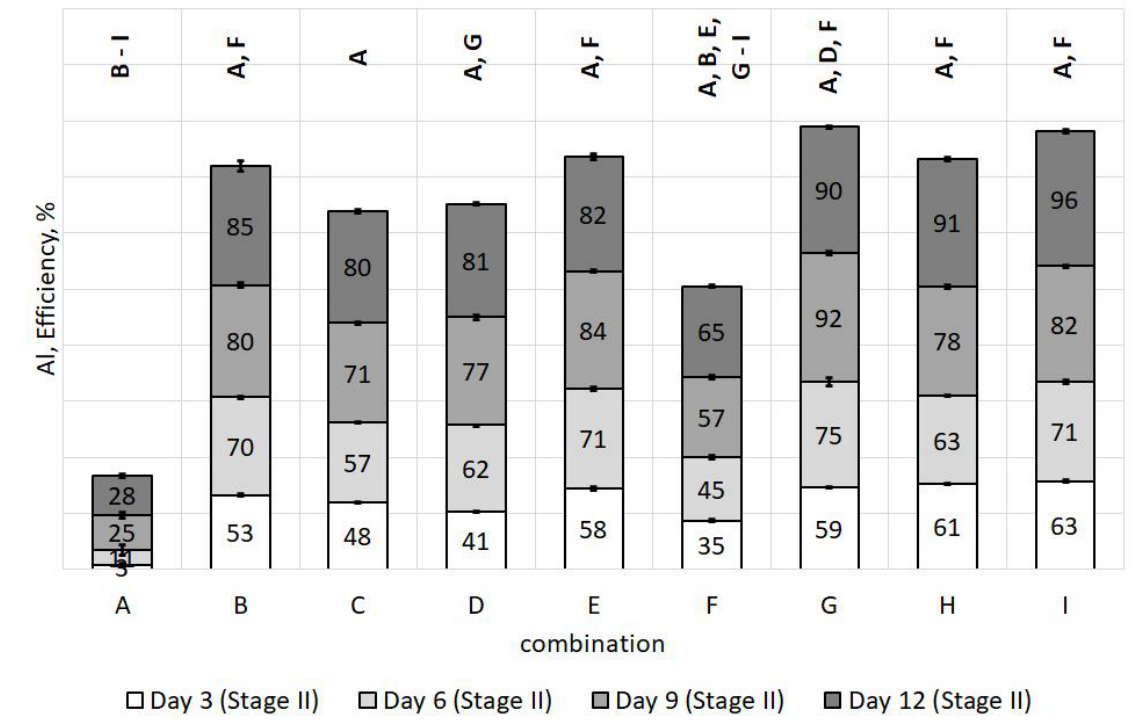
Figure 6. Effectiveness of Al release to the dissolved fraction of leachate (Stage II).